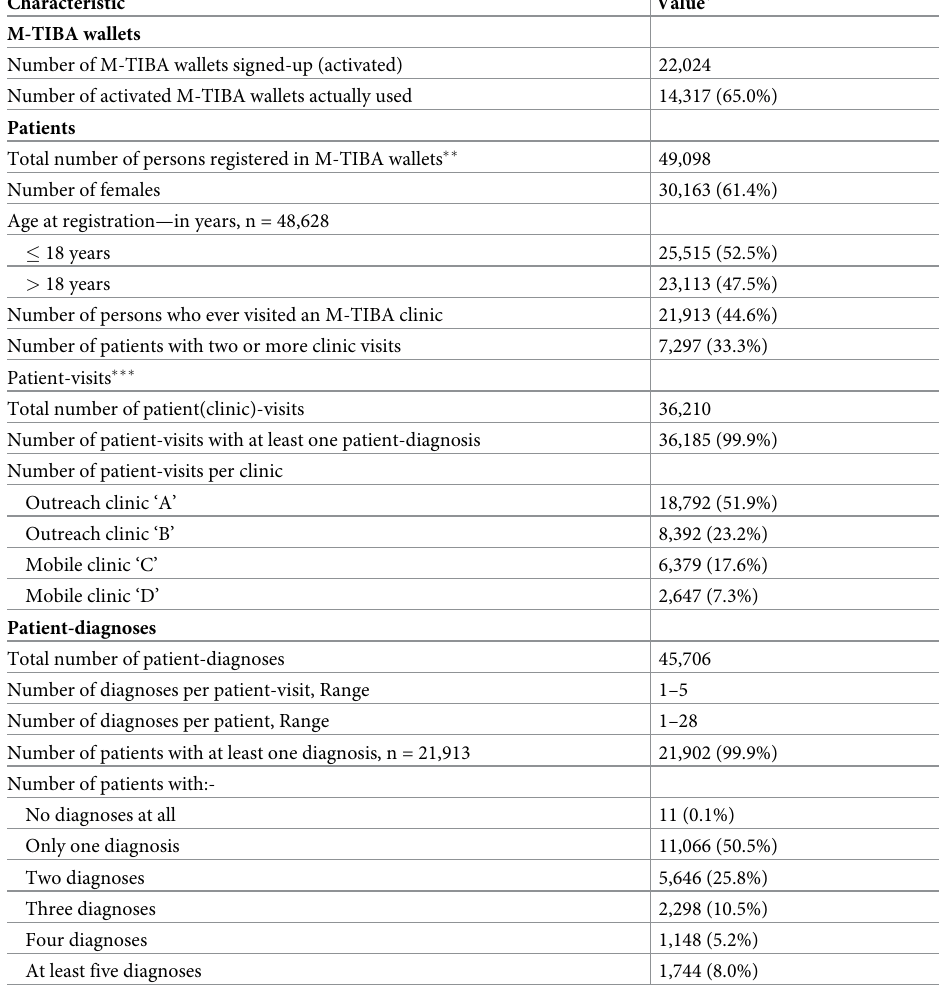
Table 1. Characteristics of M-TIBA wallets, patients, patient-visits and diagnoses made at the study clinics between April 1 and December 27, 2016, in Nairobi, Kenya. Characteristic Value � M-TIBA